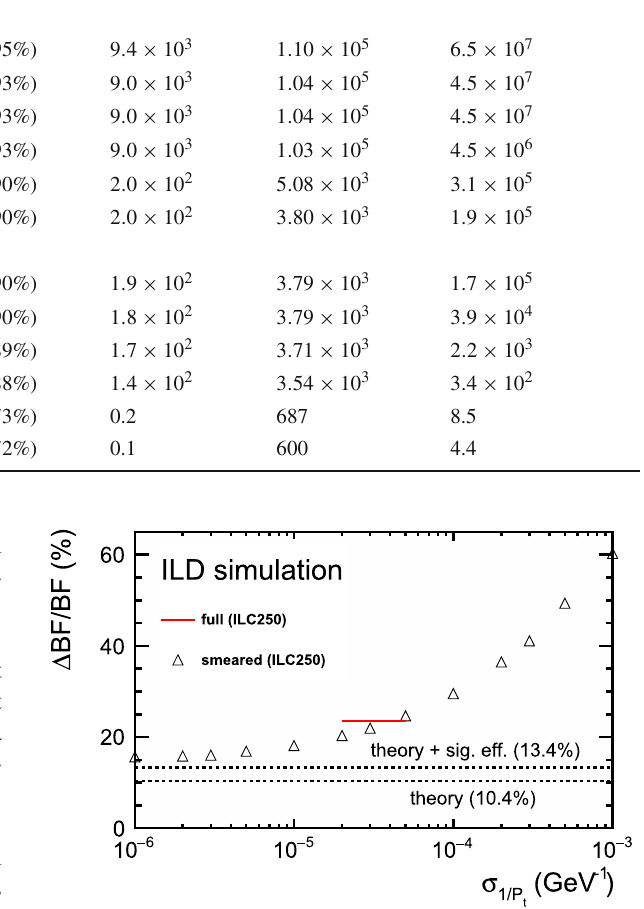
Table 11 Detailed cut flow of the qqH250-L channel. The numbers in brackets show the signal selection efficiency